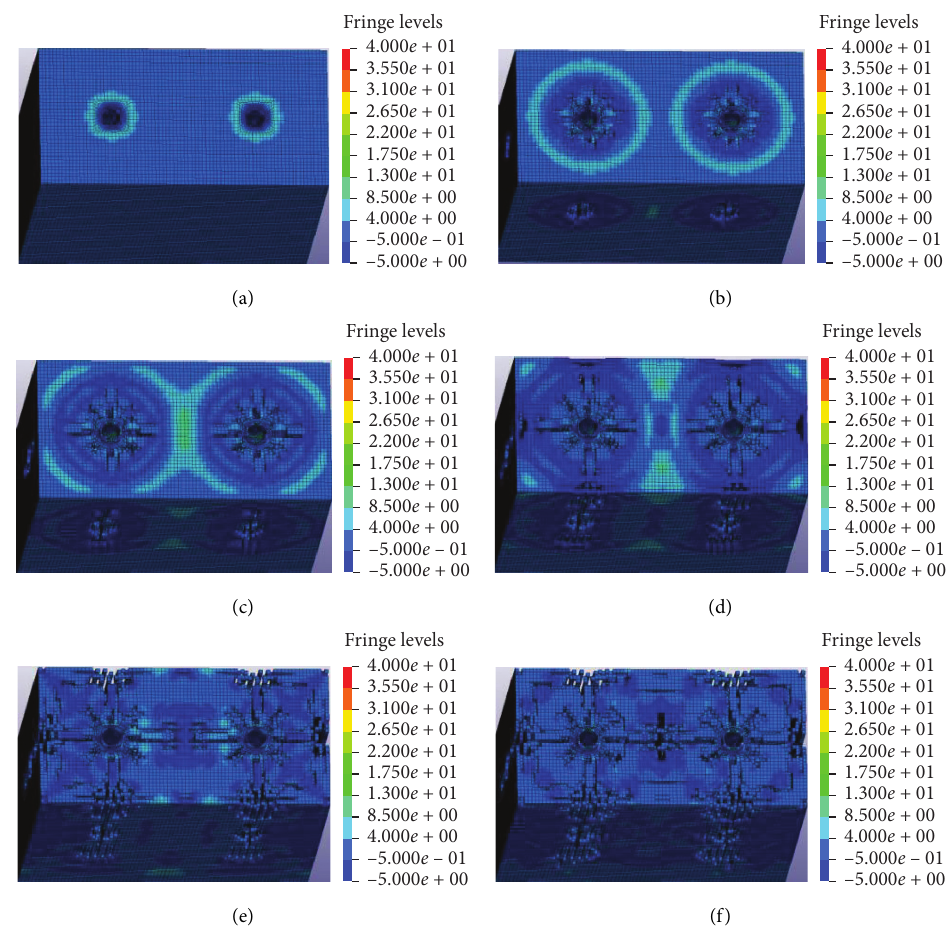
Figure 8: The whole process of a loading concrete beam segment with single-row holes. (a) t � 55 μ s. (b) t � 75 μ s. (c) t � 85 μ s. (d) t � 95 μ s. (e) t � 120 μ s. (f) t � 160 μ